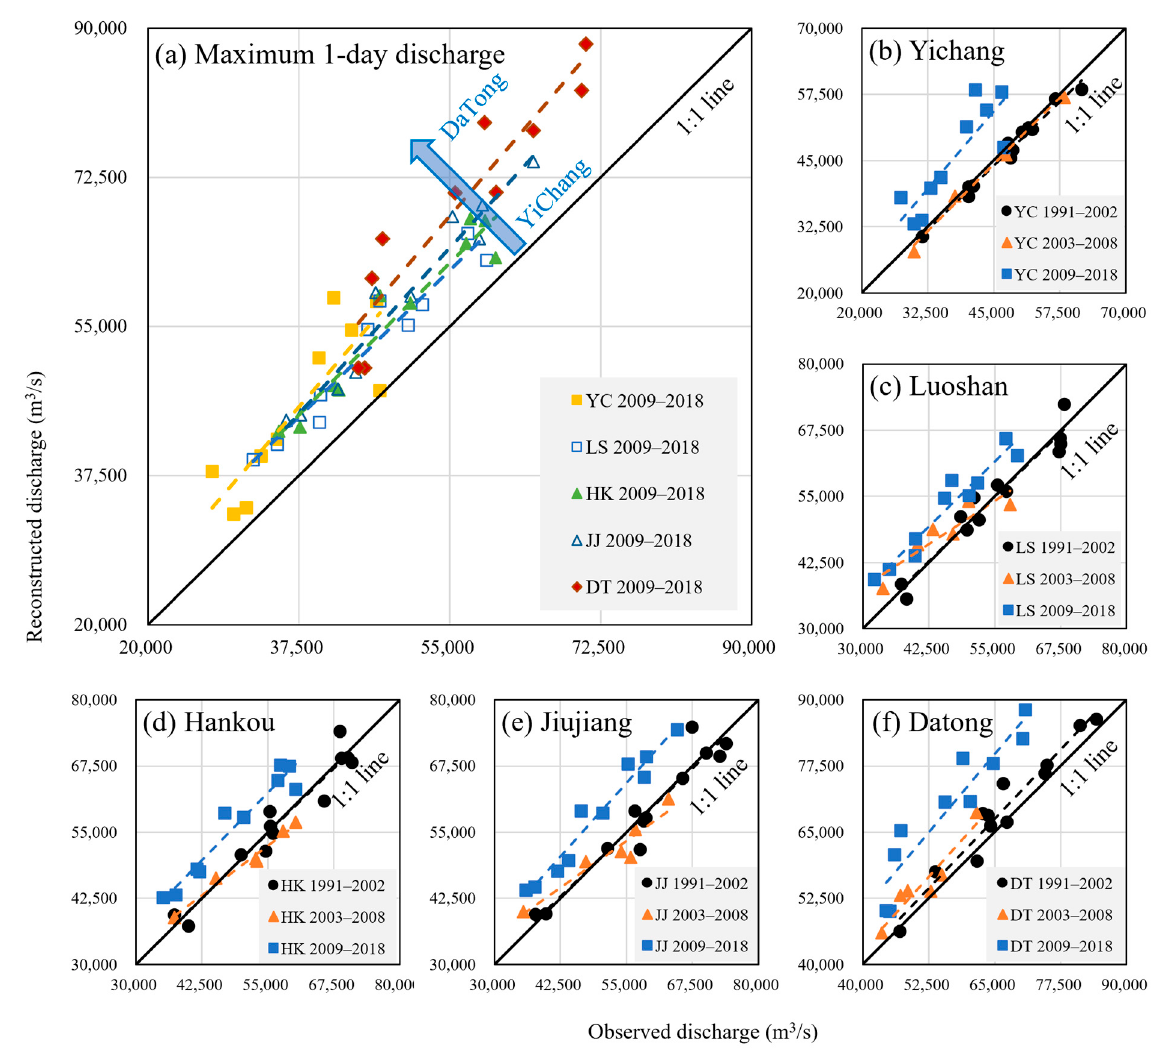
Figure 7. Comparison of the maximum 1-day discharge during flood season between the five gauging stations. If points are above the 1:1 line, the reconstructed discharge is greater than the observed discharge, and the TGD has reduced the maximum 1-day discharge. In contrast, if points are below the 1:1 line, the reconstructed discharge is less than the observed discharge, and the TGD has increased the maximum 1-day discharge.